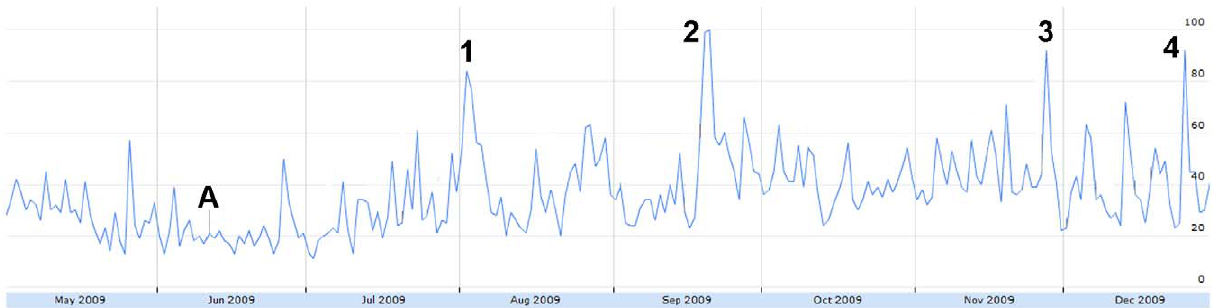
Figure 11. The relative proportion of tweets expressing misinformation from May 1 to December 31, 2009. Figure was scaled to the highest peak on Sept. 20 where 1.93% of all tweets expressed misinformation. The peak was assigned a score of 100. A=June 11: WHO pandemic level 6 announcement. 1=Aug 2: CBS reports on parental concerns about H1N1. 2=Sept 18–21: Ten swine flu lies told by the mainstream media. 3=Nov 27: WHO and drug companies in collusion. 4=Dec 25: Carbon monoxide poisoning can create same symptoms as H1N1.